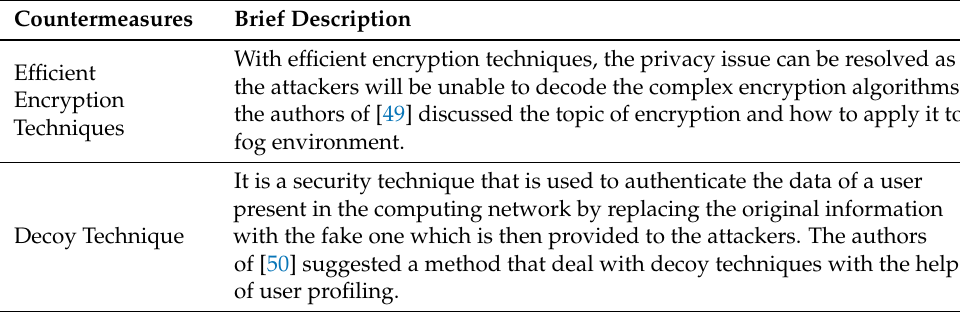
Table 4. Security attacks and privacy-preserving